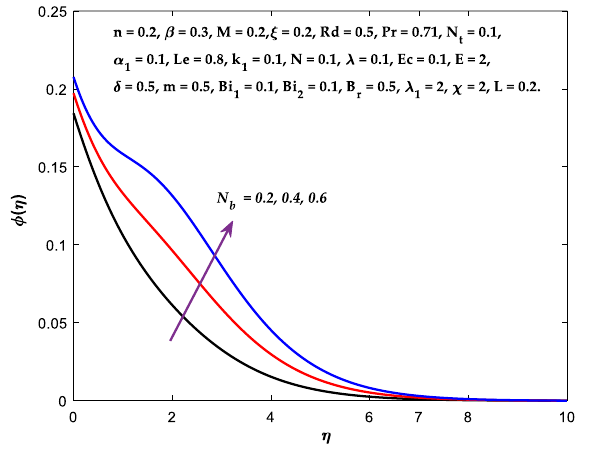
Figure 14. Diagram of N b v/s φ(η) .